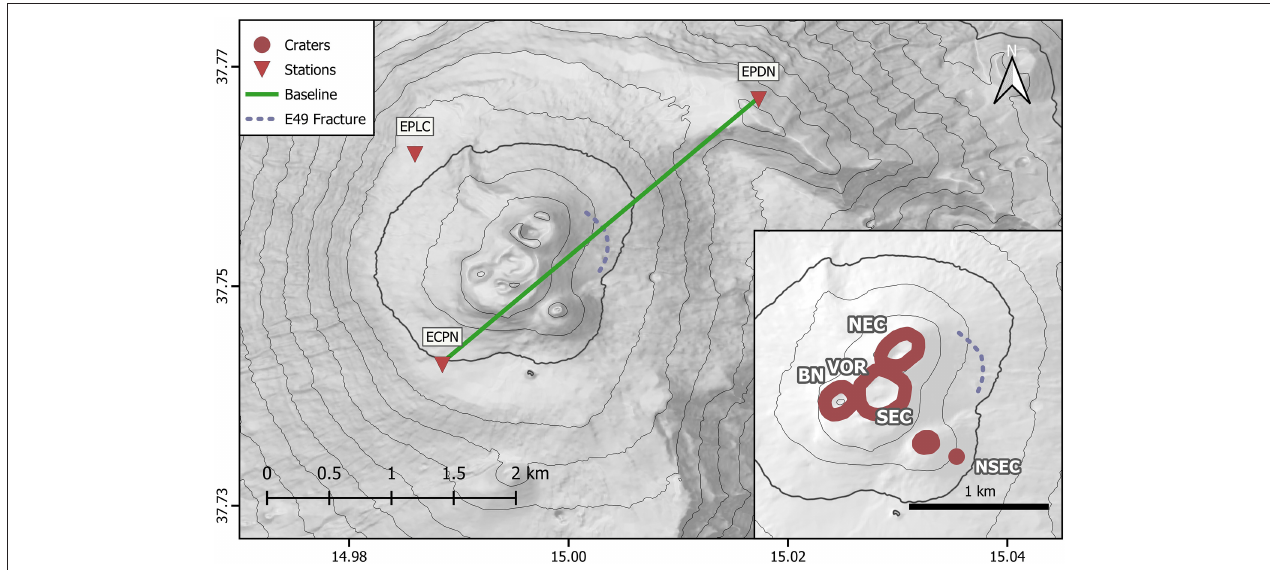
FIGURE 1 | Digital elevation model with the three seismic stations used in this study (red triangles). The green line corresponds to the GPS baseline ECPN-EPDN in Figures 3 , 4 . The lower right inset shows the volcano summit craters (NEC, North-East Crater; BN, Bocca Nuova; SEC, South-East Crater; NSEC, New South-East Crater; VOR, Voragine). The purple dashed line is the approximate extent of the E49 fracture system. The stations are < 5km apart and station ECPN is the closest to NSEC, the most active crater for the studied